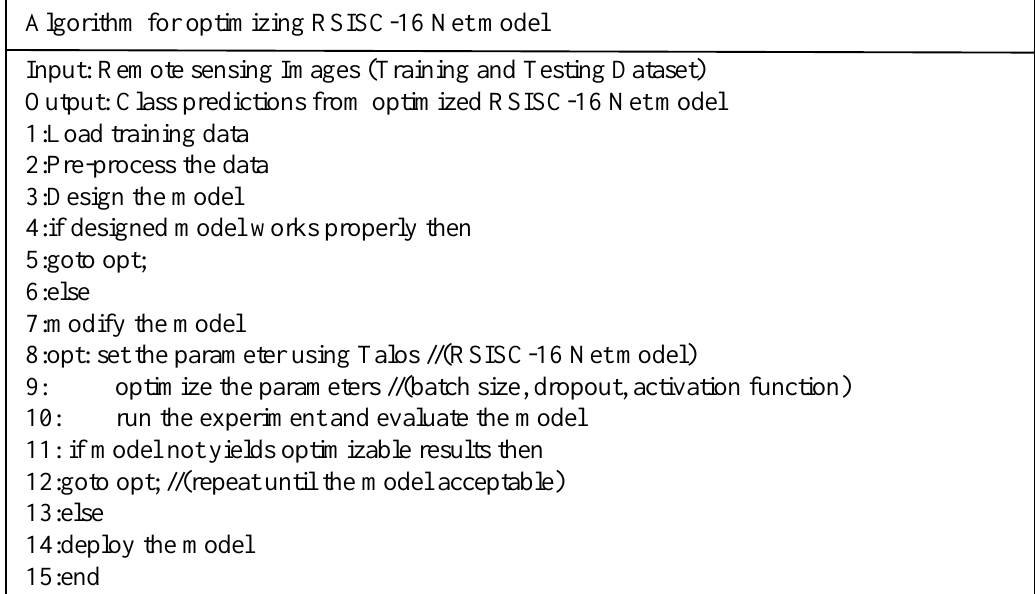
Algorithm for optimizing RSISC-16 Net